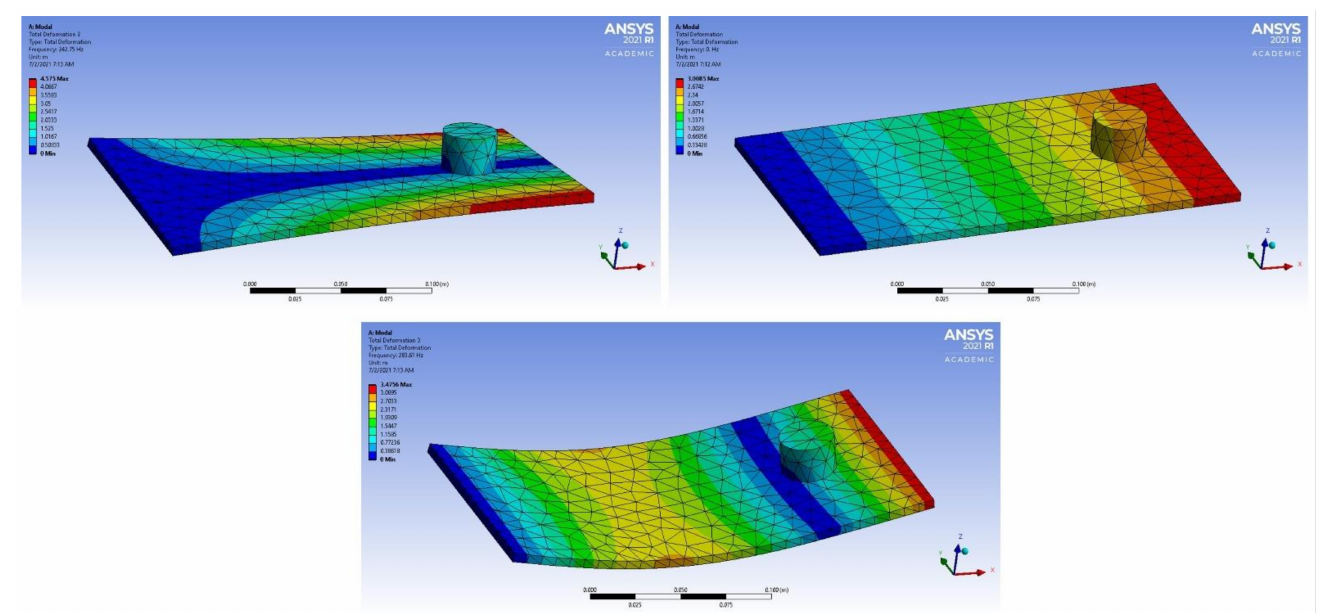
Figure 10. Mode shapes of magnesium using the modified